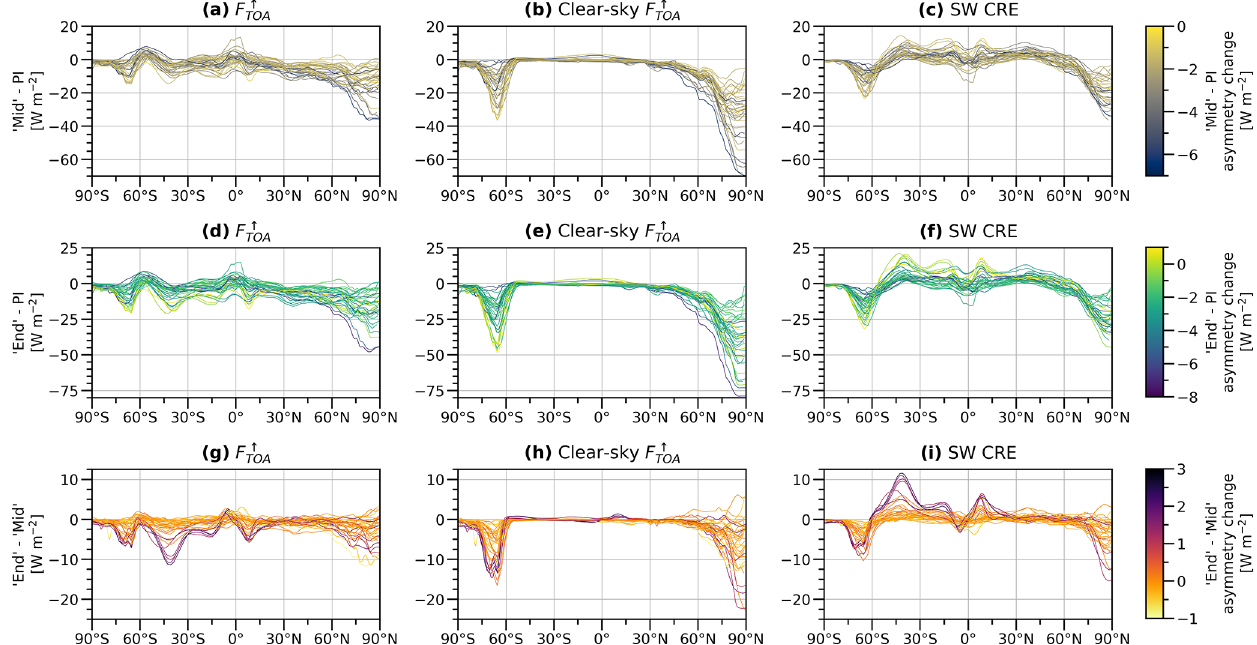
↑ , as well as SW CRE between (a–c) Mid and PI conditions, TOA